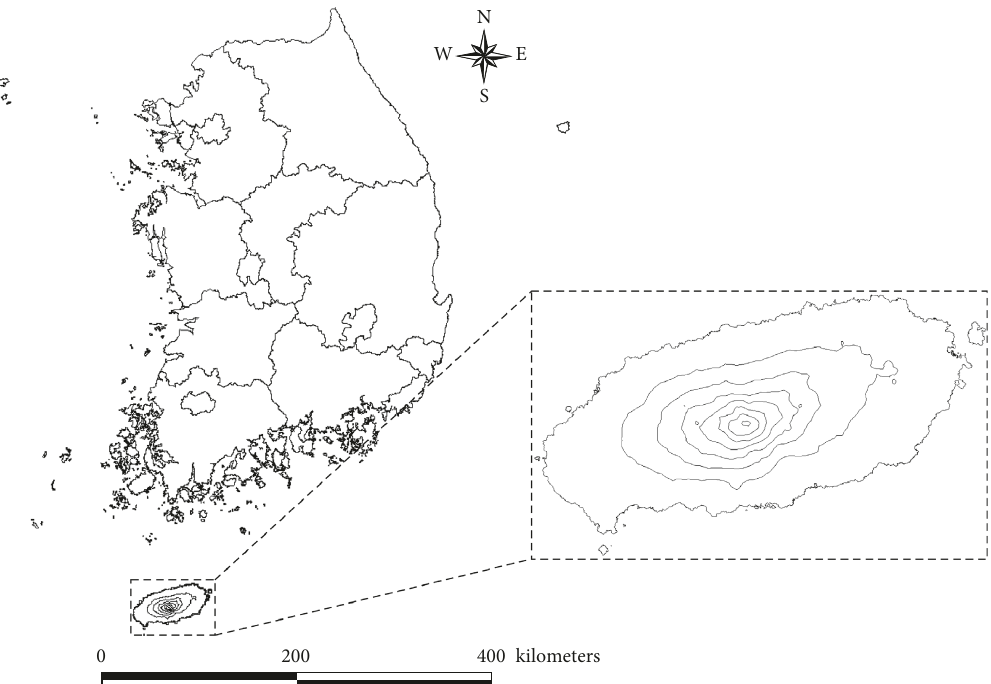
Figure 3: Location of Jeju Island, Korea (the contour lines over Jeju Island represent the 250m altitude